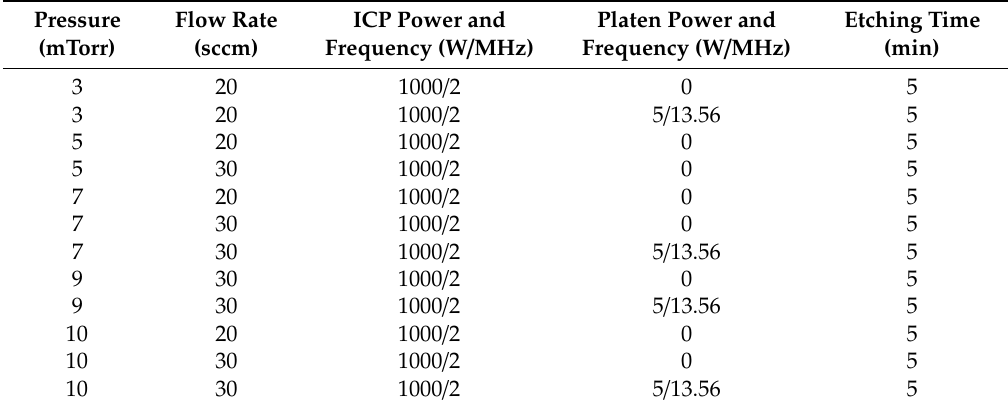
Table 2. Etching parameters.